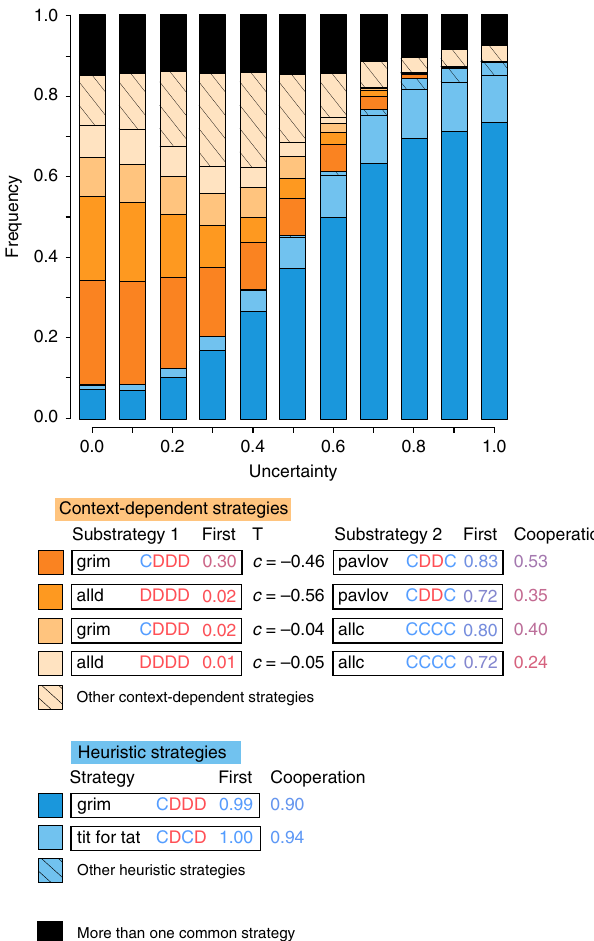
Fig. 3 The most common context-dependent and heuristic strategies that evolved for various levels of uncertainty about social situations. Each bar shows the fractions of 5000 replicate simulations that were dominated by the strategies shown below (a strategy was considered to dominate if it constituted more than 80% of the population by the end of the evolutionary simulation). The most common context-dependent strategies are shown in orange. These strategies are de fi ned by two substrategies and a threshold ( T ; if the individual perceives c to be below this value, substrategy 1 is implemented; otherwise, substrategy 2 is implemented). Each substrategy is de fi ned by fi ve genes, which determine whether the individual cooperates (C) or defects (D) given the outcome of the four possible outcomes of the previous round (Fig. 1), and by a locus that determines the probability that the individual cooperates in the fi rst interaction round. The last column gives the cooperation rate in a population that consists only of individuals implementing the given strategy. The most common heuristic strategies are shown in blue (these implement the same strategy independent of speci fi cs of the social interaction at hand). Black bars show simulation runs in which no single strategy achieved a frequency above